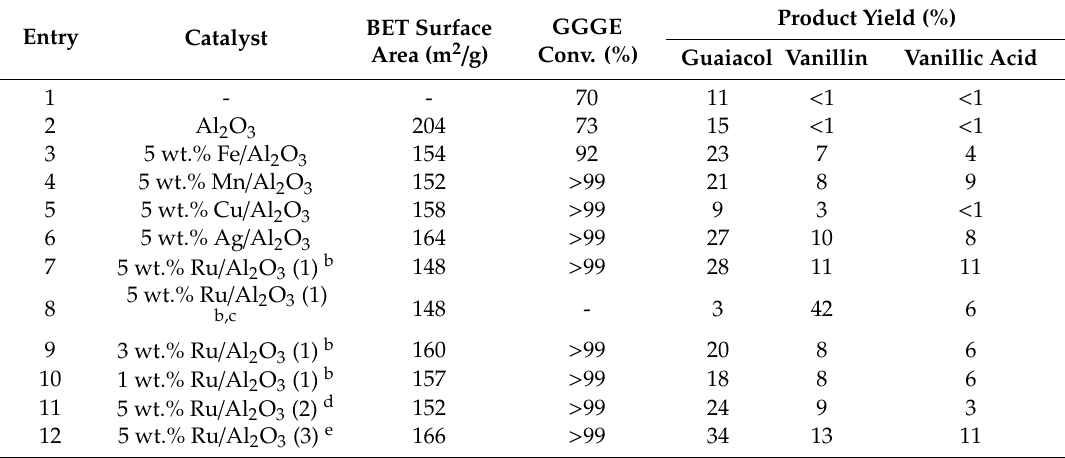
GGGE Conv. Area (m 2 / g)